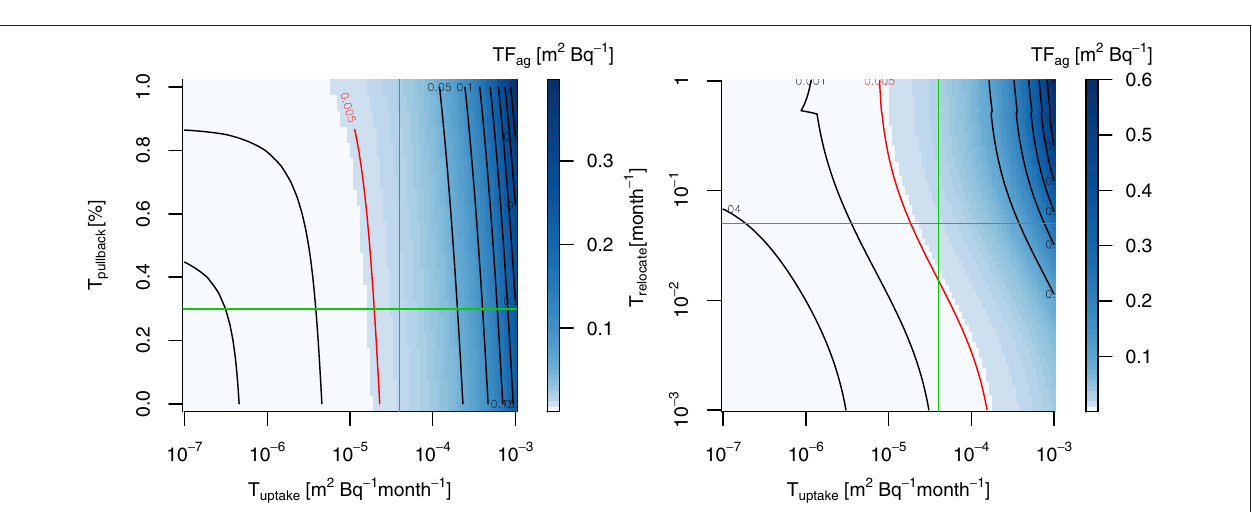
FIGURE 4 | Sensitivity test of T uptake , T pullback , and T relocate for TF ag (m 2 kg − 1 ) of unmanaged forest, 30 years after the FDNPP fallout event. Red lines indicates the averaged TF ag values in the literature for coniferous forest (Calmon et al., 2009). Green lines indicates the values used in this study.